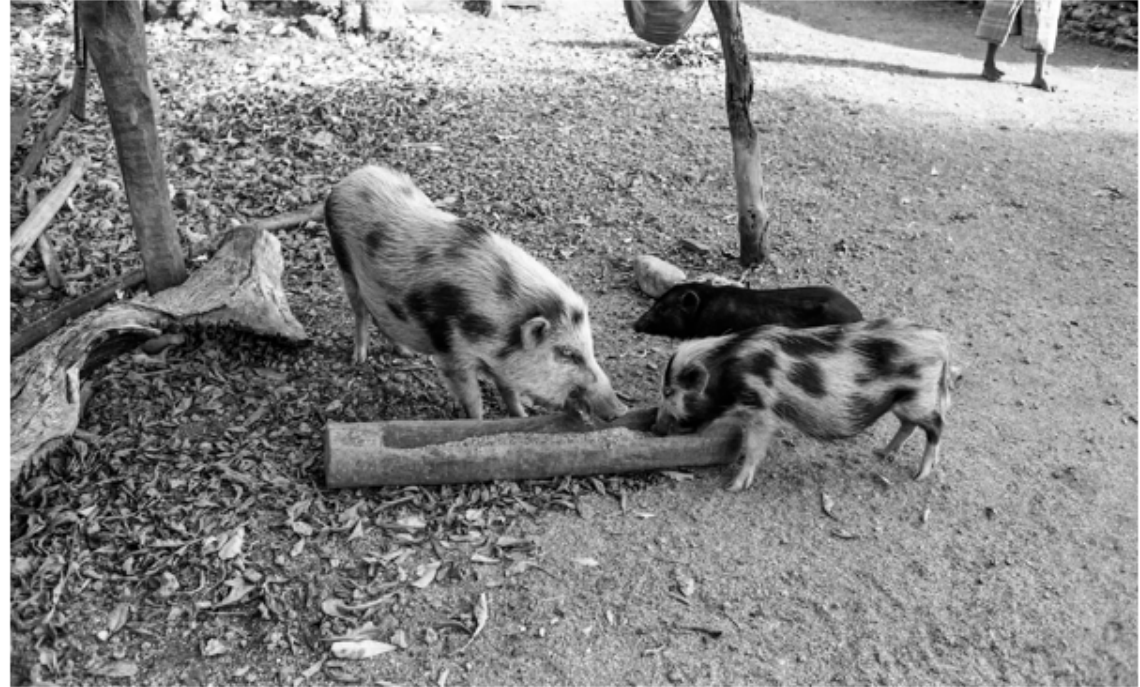
Figure 3. Village pigs on the eastern Indonesian island of Rote. Anthropologist James Fox took this photograph in or around 1972. These pigs are among a population identified by Colin Groves [14], based on Fox’s images, as domesticated variants of S. celebensis , based both on their status as village pigs that lived with humans and the presence of external morphological characteristics associated with domestication (e.g., piebald coats, visible in this image). Credit: J. Fox. Current evidence generally supports Groves’s original claim that S. celebensis is (or was) found well outside its natural range. For example, empirical support for the presence